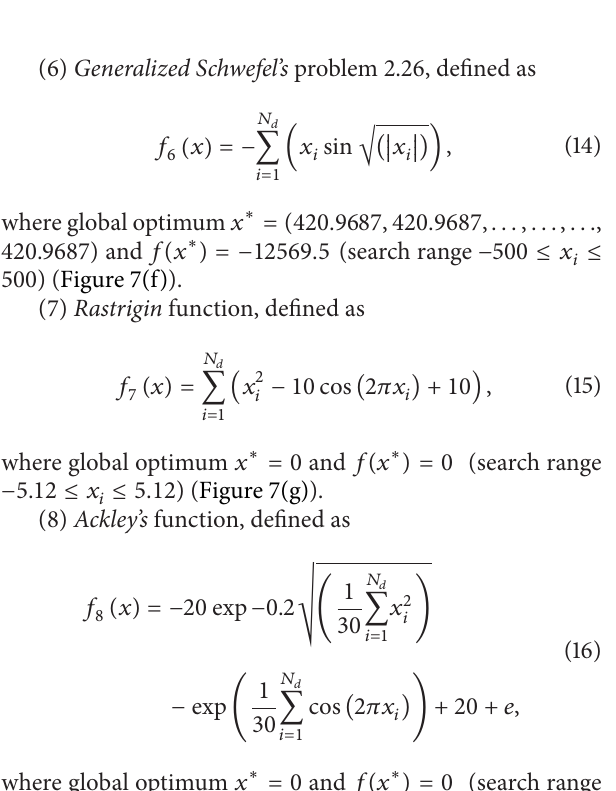
Algorithm 1: The pseudocode of cellular harmony search